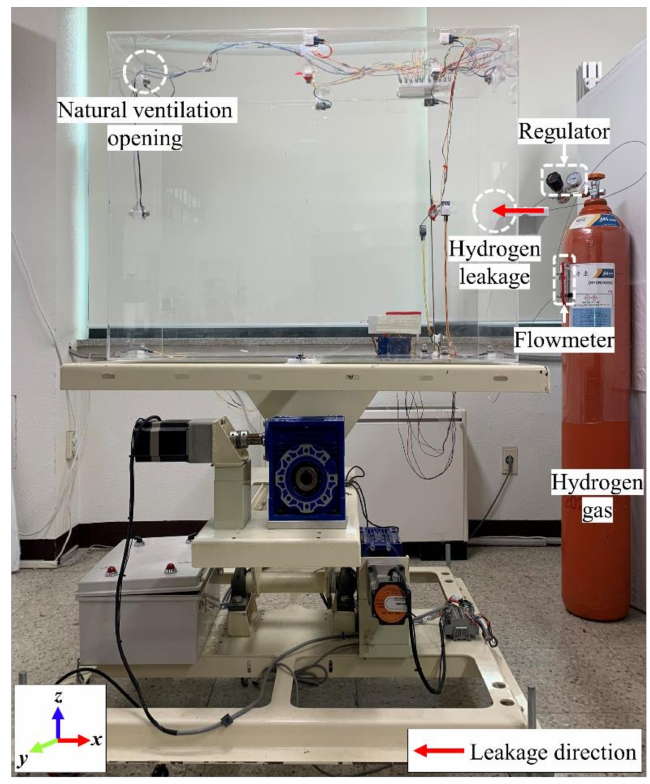
Figure 2. Schematic of experimental setup.